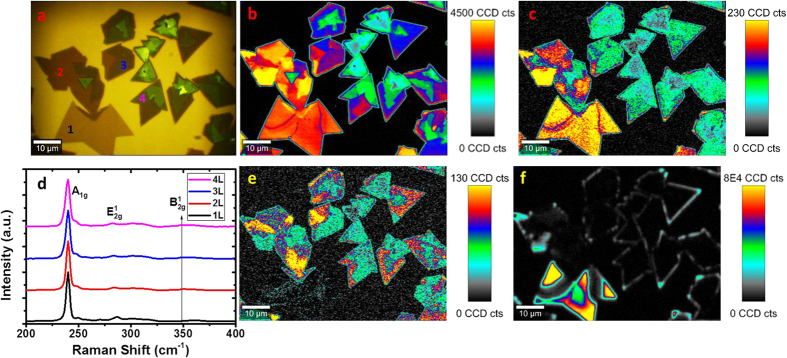
(a) Optical image of CVD-grown MoSe2 with varying layer numbers. (b) Peak intensity map of A’1/A1g (~ 240 cm−1) Raman mode for MoSe2. (c) Peak intensity map of E’/Eg/E12g (~287 cm−1) Raman mode. (d) Raman spectra of 1–5 L MoS2 normalized to A’1/A1g mode intensity. (e) Peak intensity map of B12g (~350 cm−1) mode. (f) PL intensity map.